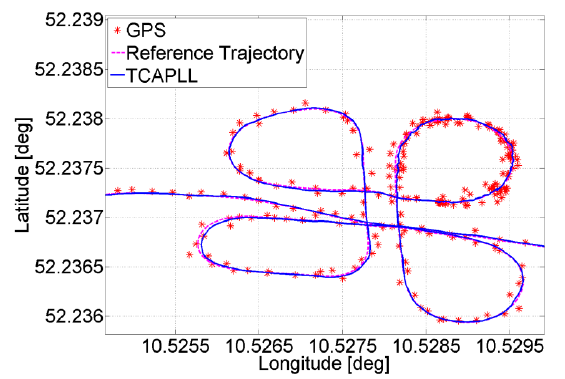
Figure 8. Comparison of the position solution of the TCAPLL and the stand-alone GPS.